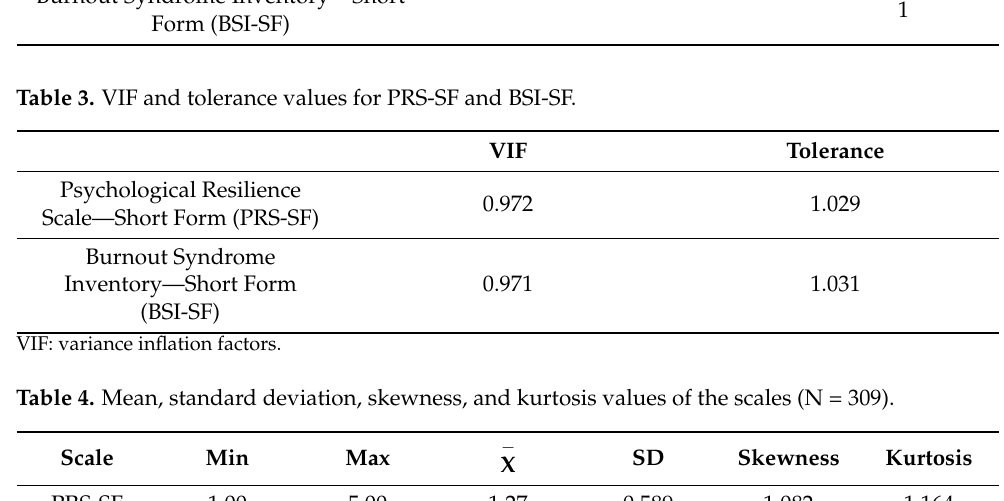
Table 3. VIF and tolerance values for PRS-SF and BSI-SF.